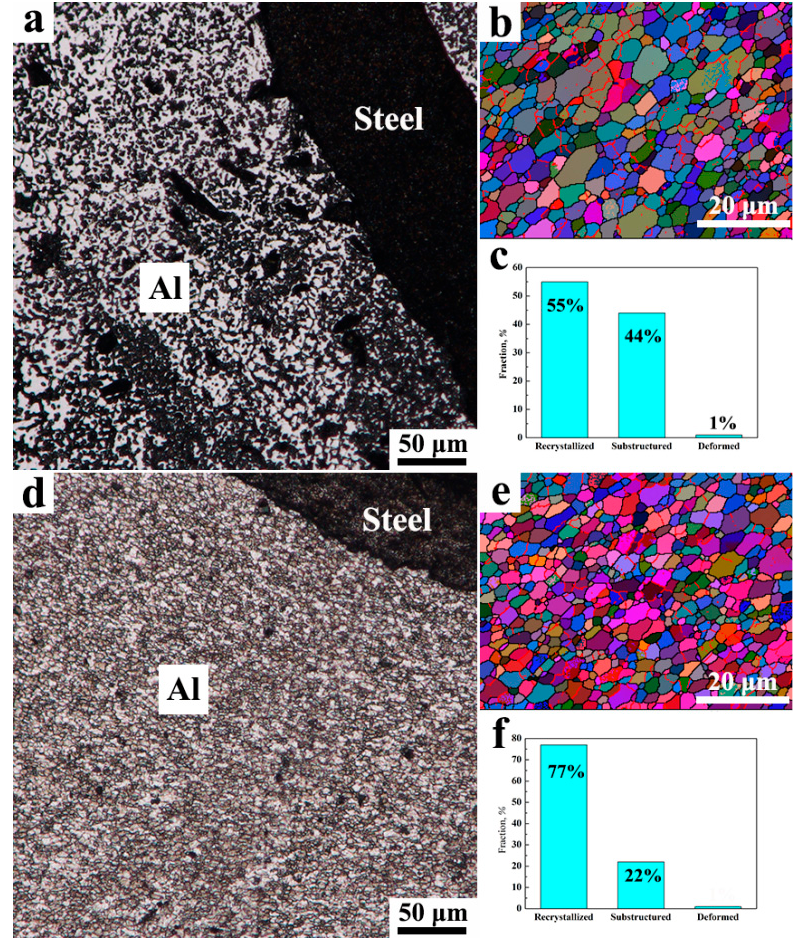
Figure 8. The grain morphology in the NZ of ( a ) FSW and ( d ) UaFSW joint observed by OM; the grain information in the NZ of ( b ) FSW and ( e ) UaFSW joint analyzed by EBSD; the recrystallization fraction in the NZ of ( c ) FSW and ( f ) UaFSW joint.